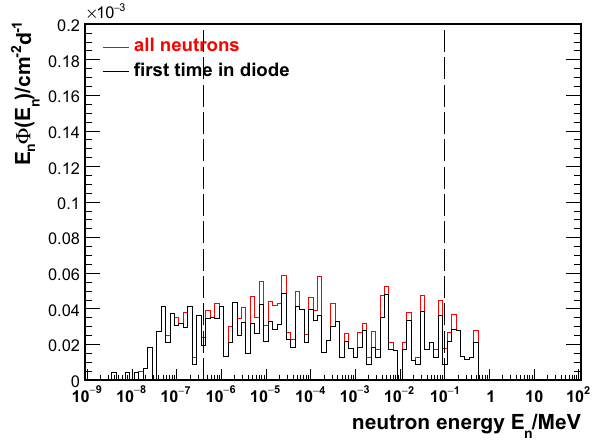
Fig. 24 Spectrum of reactor-neutron-induced neutrons at one CONUS HPGe diode predicted by MC a count rate of at least a factor of 5 lower. This means that